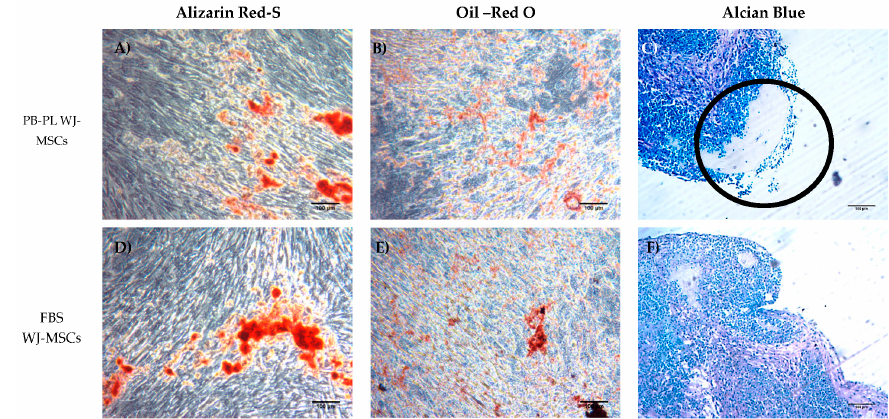
adipogenic and chondrogenic lineages. ( A , D ) Staining of the PB-PL and FBS expanded WJ-MSCs